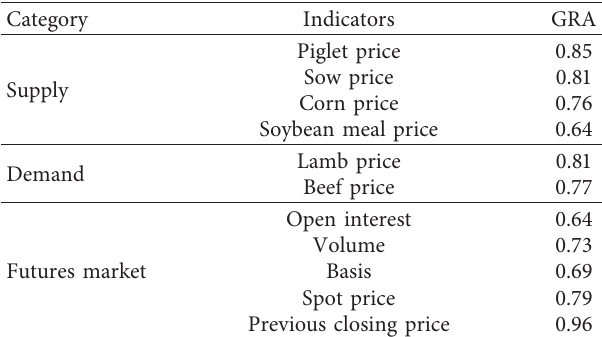
Table 2: Results of GRA.